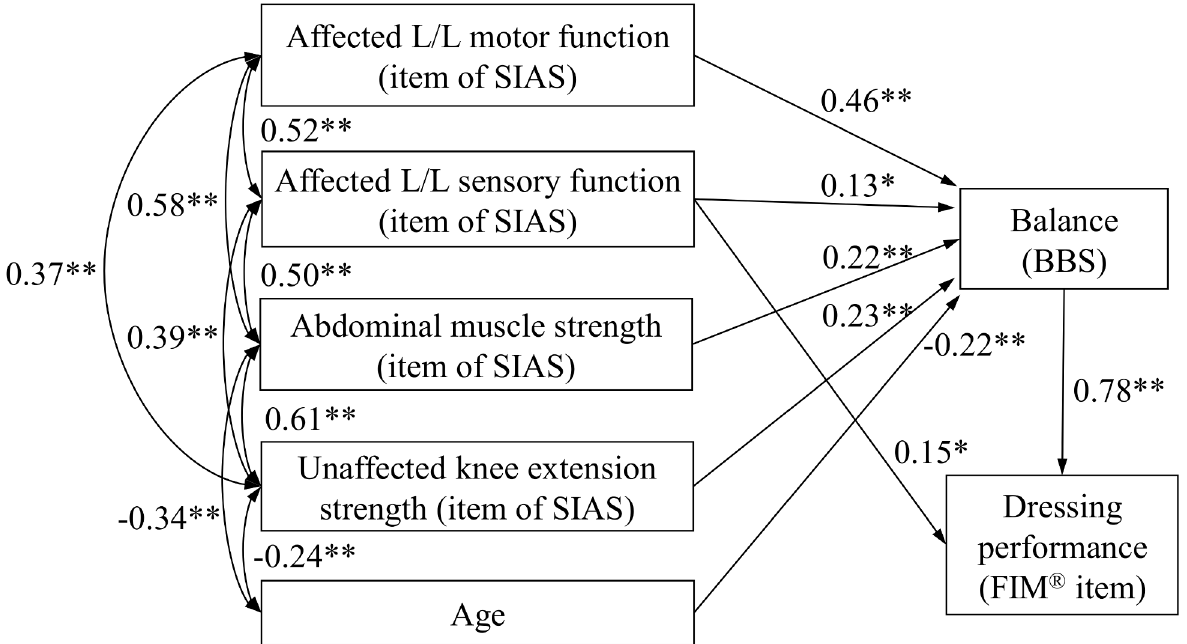
Fig 2. Modified model of the path diagram with the results of parameter estimates. A unidirectional arrow indicates a standardized path coefficient. A bidirectional arrow indicates a correlation coefficient. Abbreviations: L/L, Lower limb; SIAS, Stroke impairment assessment set; BBS, Berg balance scale. * P < 0.05, ** P <